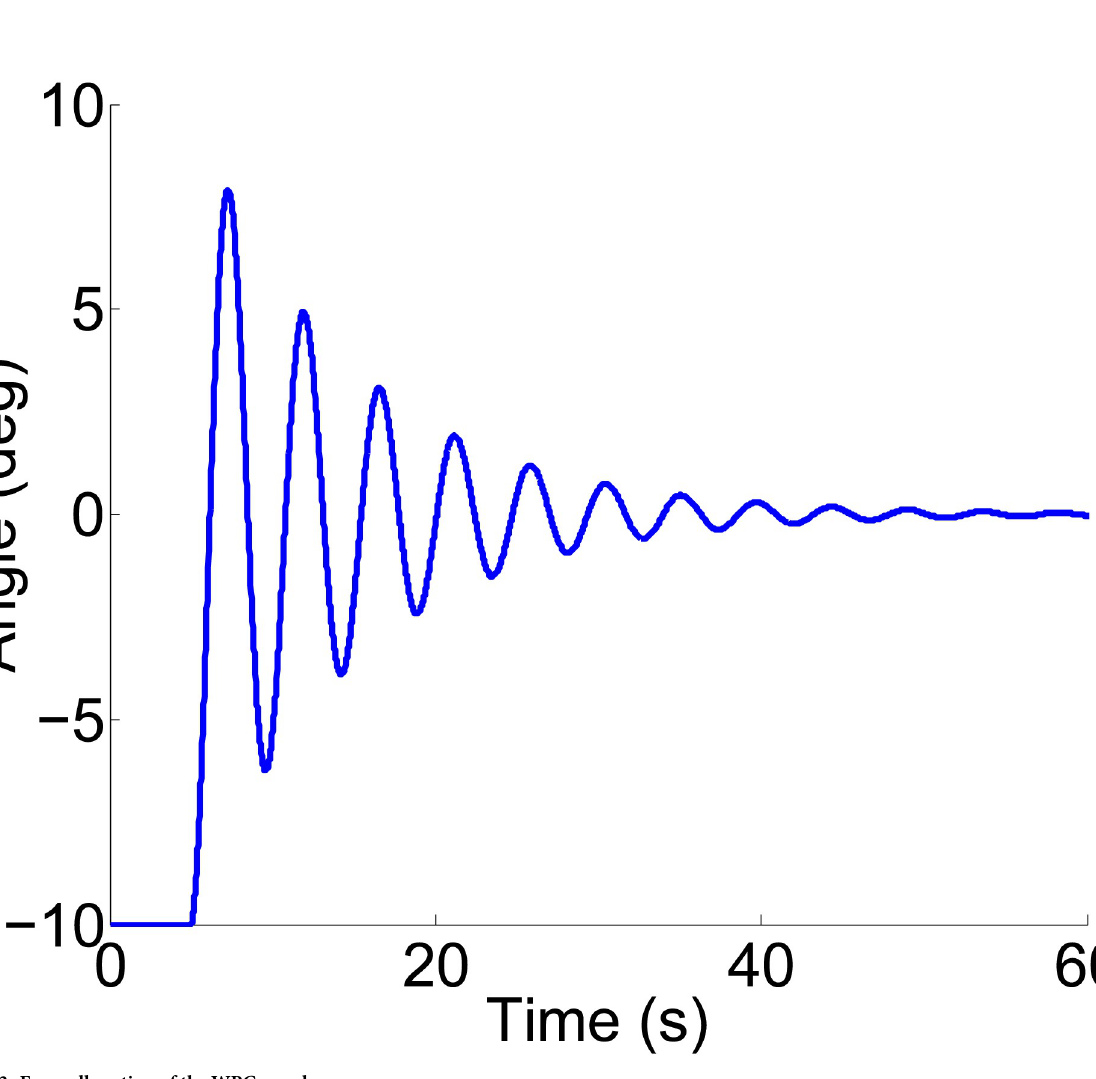
Fig 3. Free roll motion of the WPC vessel.